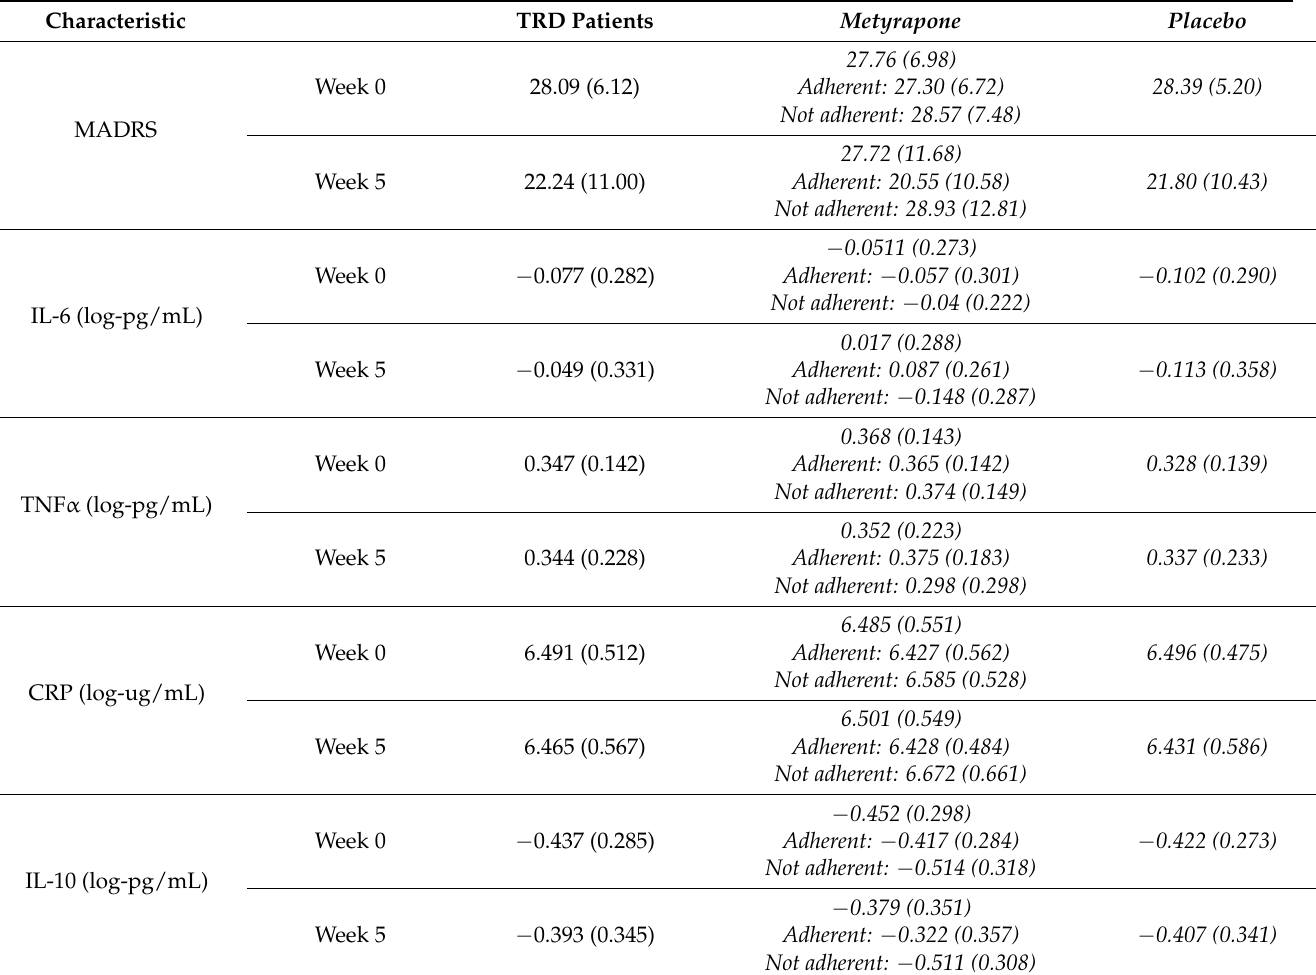
Table 2. Symptoms and inflammation throughout the trial in metyrapone and placebo